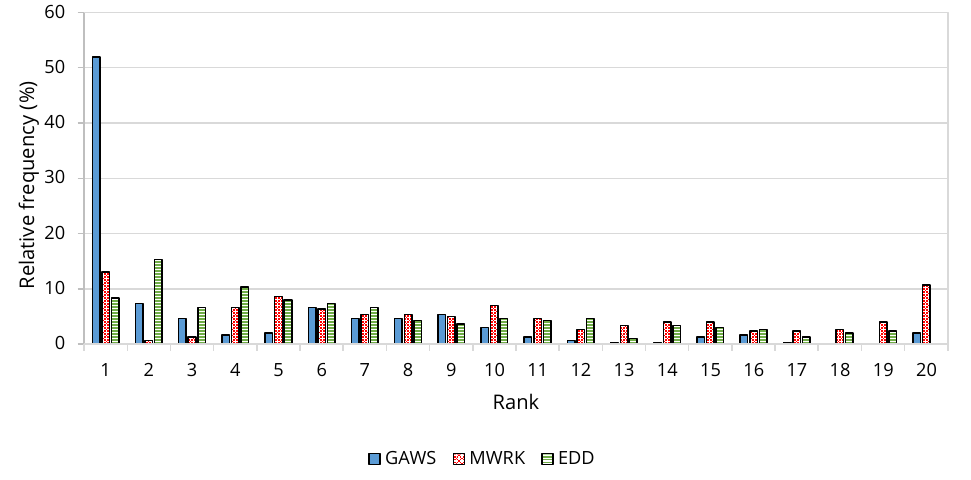
Figure 12. Comparison of the performance of the three priority rules. Table 3. Improvement with GAWS = rank